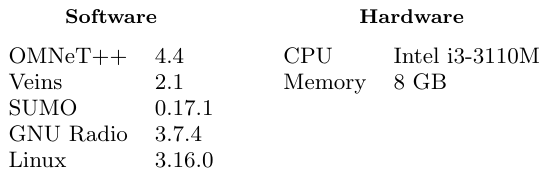
Table 1: Environment of the simulation used to con- duct data.